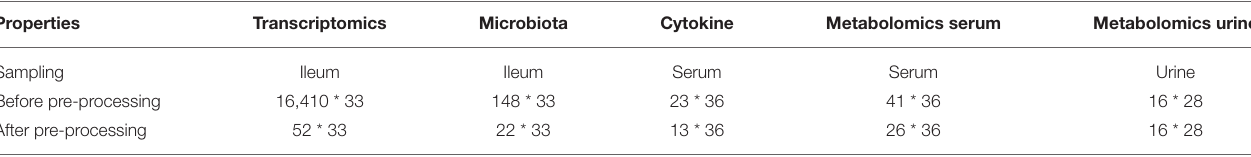
TABLE 1 | Pre-processing and specificities of each data-type.